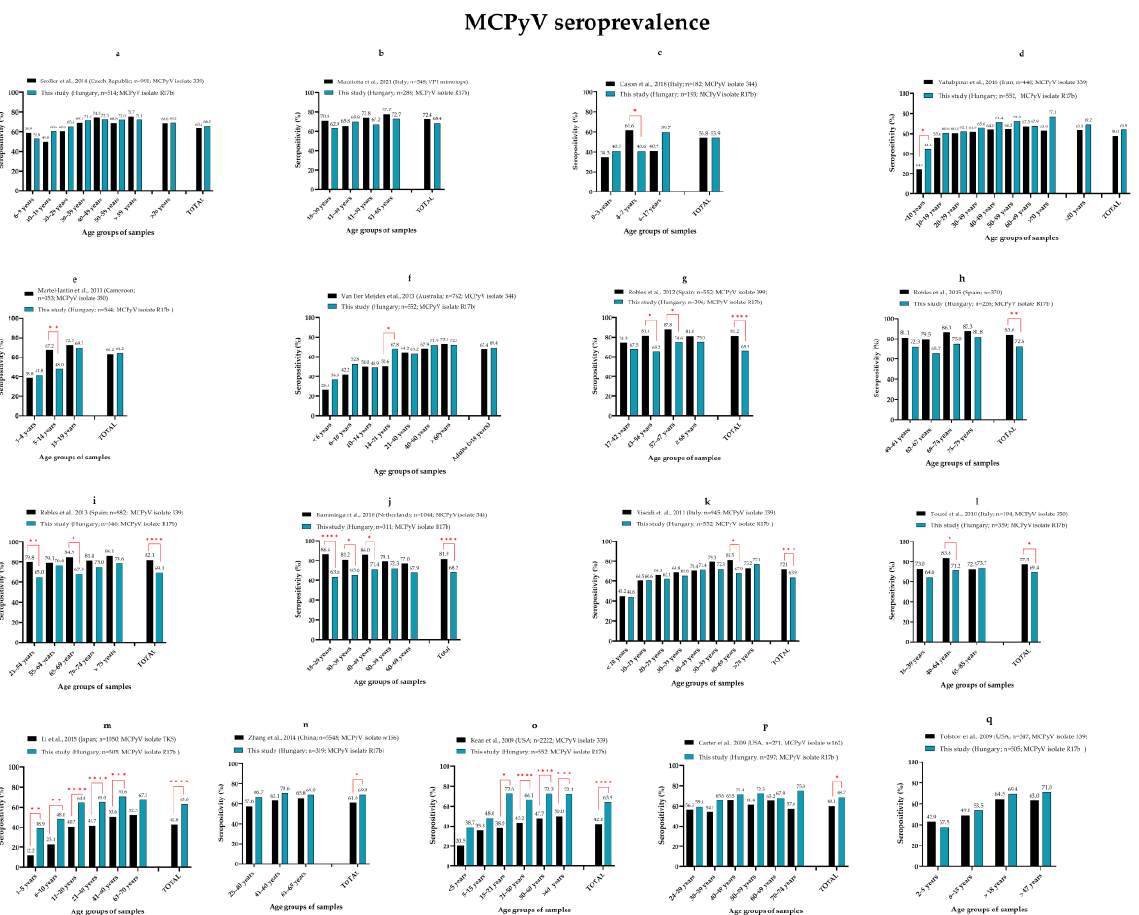
Figure 5. Pairwise comparison of age-specific MCPyV seroprevalence. Each panel represents a comparison between our results and one published study which are the followings: ( a ) [41], ( b ) [16], ( c ) [42], ( d ) [43], ( e ) [44], ( f ) [35] ( g ) [45], ( h ) [40], ( i ) [46], ( j ) [38], ( k ) [47], ( l ) [48], ( m ) [49], ( n ) [50] ( o ) [51], ( p ) [52] and ( q ) [39]. Significant differences between age groups are indicated by red lines and asterisks (Fisher’s exact test, * p ≤ 0.05, ** p ≤ 0.01, *** p ≤ 0.001, **** p ≤ 0.0001).